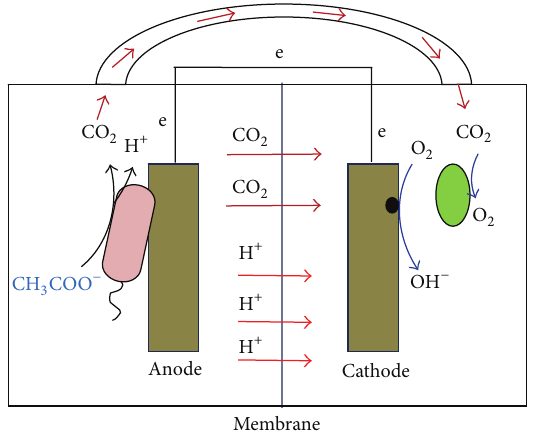
Figure 6: Schematic representation of CO 2 transportation and anode and cathode reactions